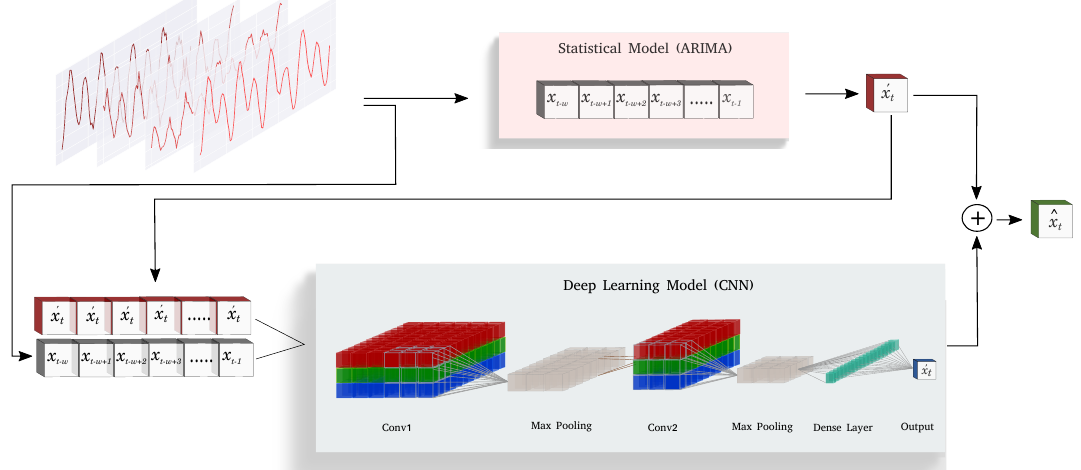
Figure 2. FuseAD forecasting